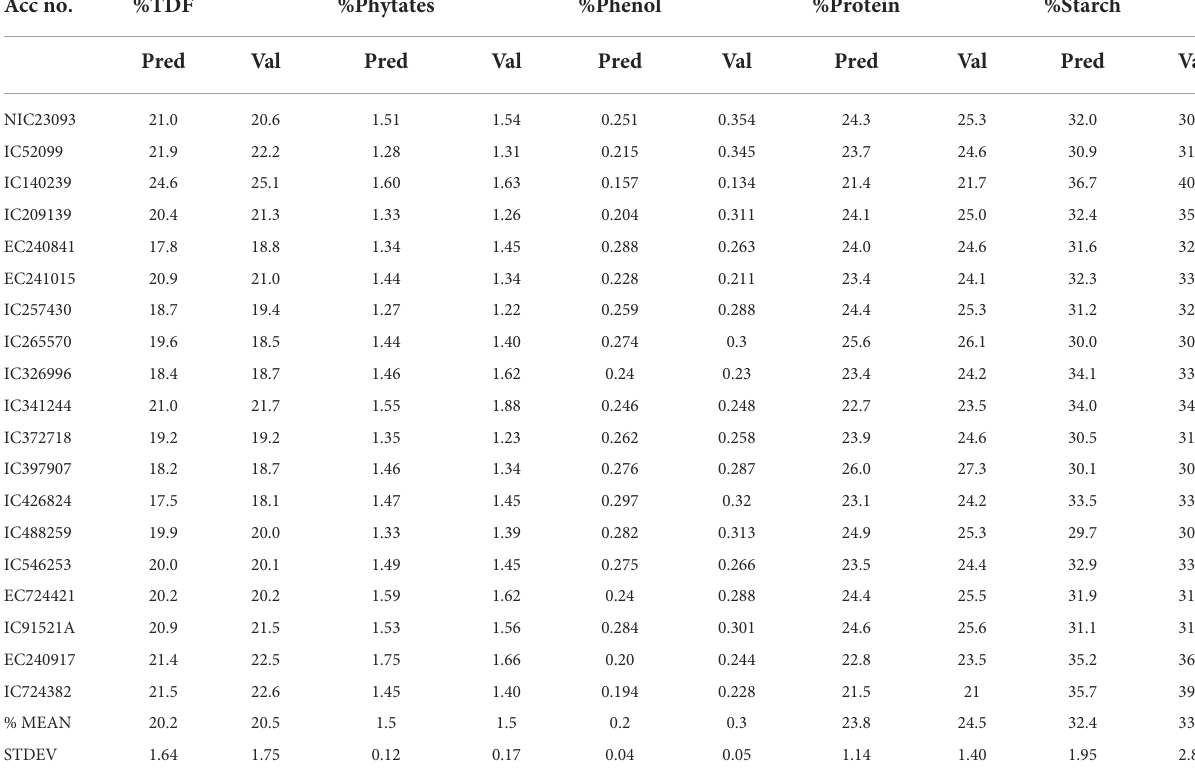
TABLE 5 Prediction and wet chemical values of selected cowpea accessions. Acc no.